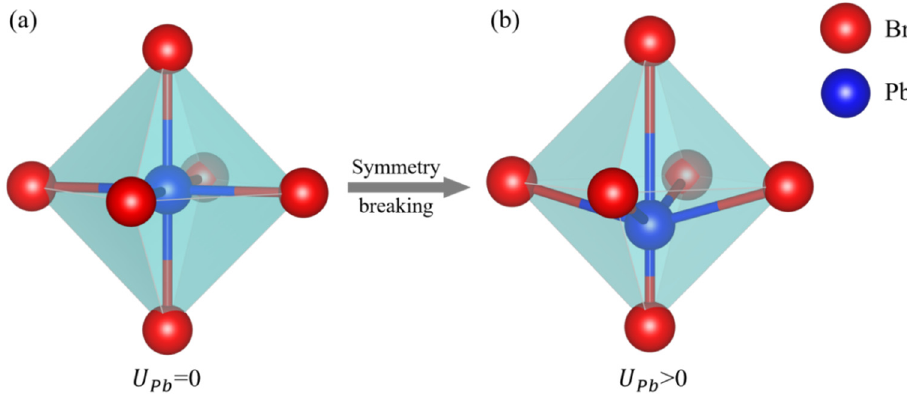
Figure 1. Different structures presented by CsPbBr 3 . ( a ) U Pb = 0 when Pb-Br bonds are in perfect symmetry distribution; ( b ) U Pb > 0 when the cell structure of CsPbBr 3 is